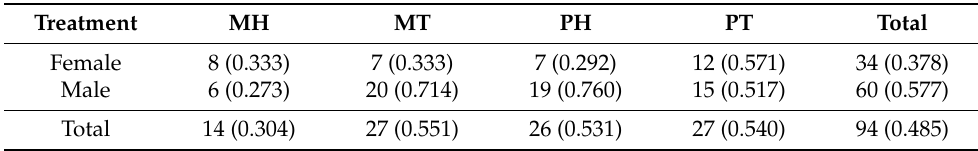
Table 4. Number (proportion) of subjects lying in the second